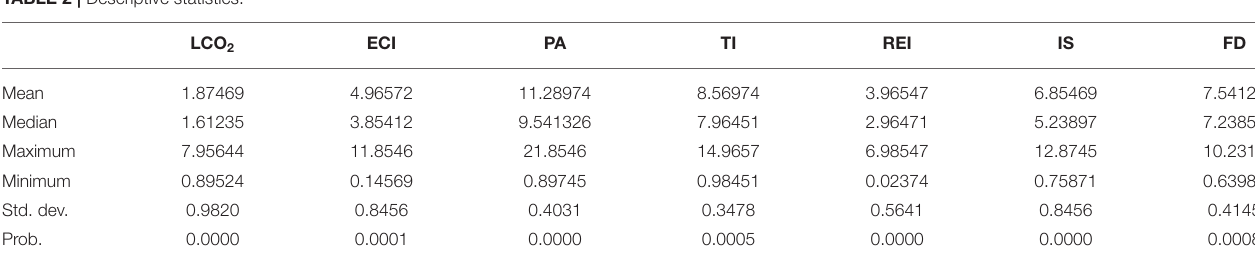
FIGURE 5 | Scatterplots economic complexity index vs. CO 2 emissions. TABLE 2 | Descriptive